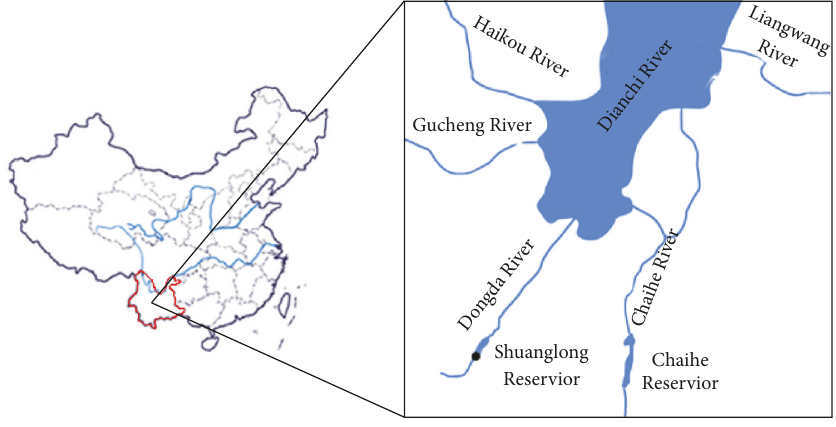
Figure 1: Location of sampling